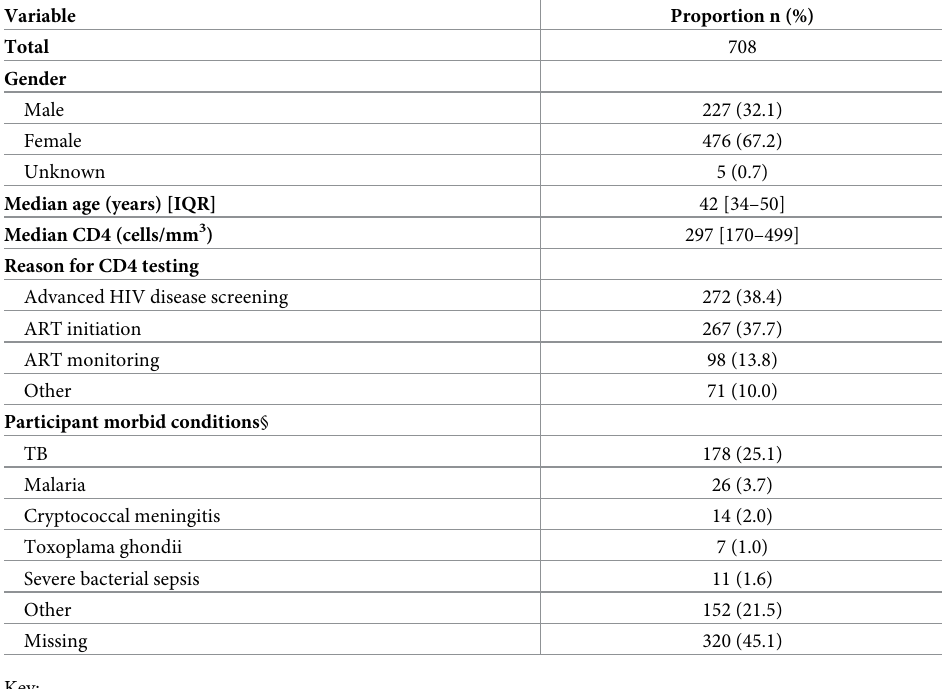
Table 1. Characteristics of study participants in Phase